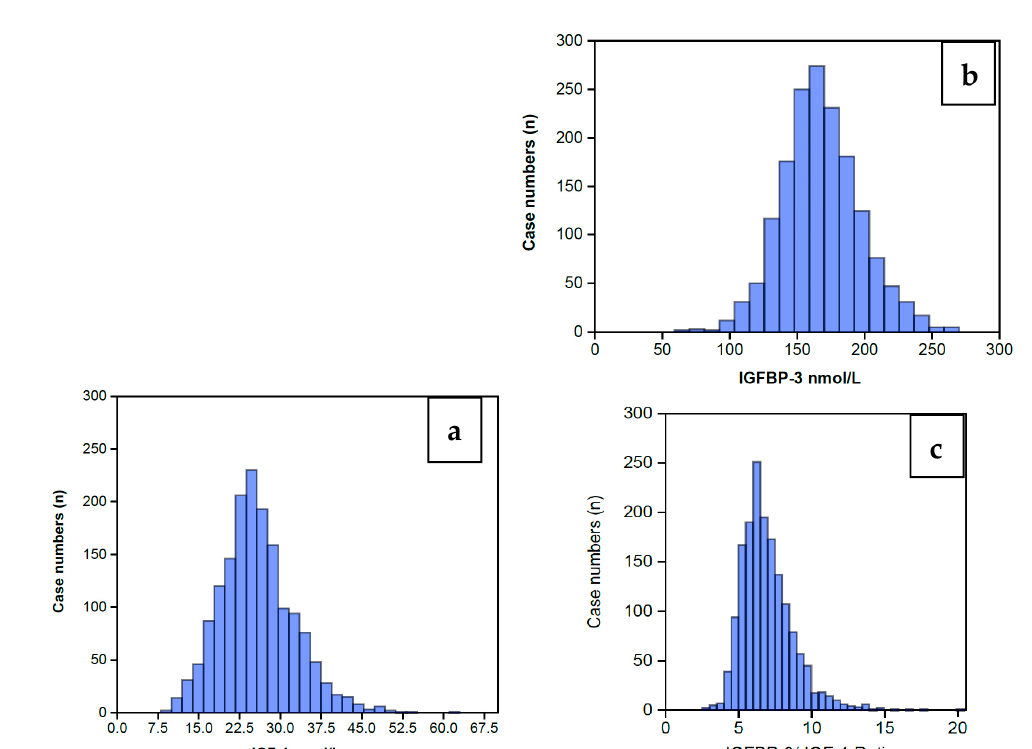
Figure 2. Histograms showing the overall IGF-1 profile for those 1633 women who completed the IGF-1 assay ( a ) along with the IGFBP-3 assay ( b ) on the same serum sample. The IGFBP-3 / IGF-1 ratio is calculated from these levels ( c ). It can be seen that all the histograms display a Normal distribution, albeit with some minor skew to the right, maximally pronounced in the Ratio. Table 1. Shows the summary statistics for the IGF-1 profile for the 1633 women who completed an